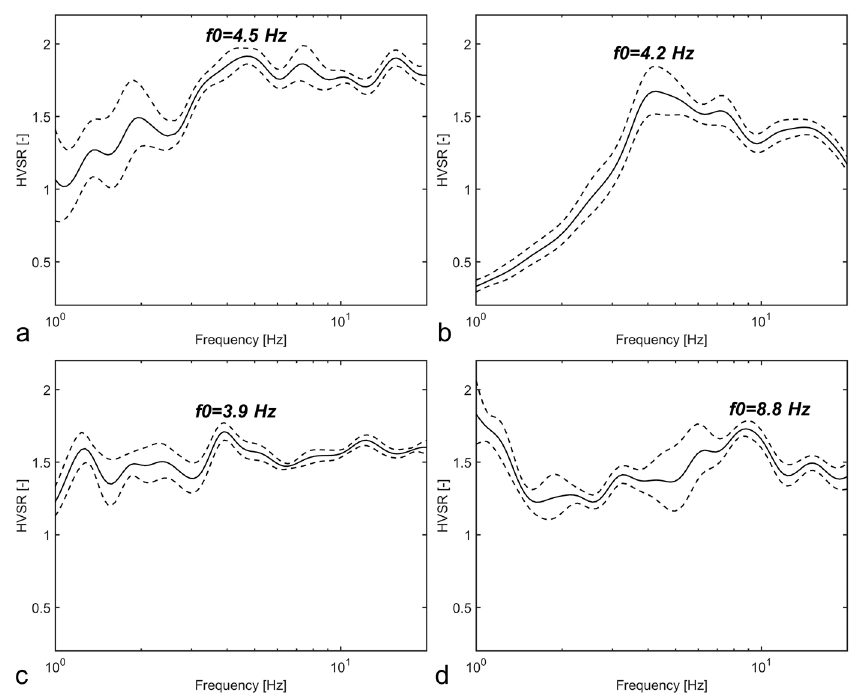
Figure 7. HVSR results on stations ( a ) A, ( b ) B, ( c ) C and ( d ) D (location in Figure 2). In each panel, the black bold and dashed curves are the average and standard deviation obtained from all the accepted 120-s window curves for each station.